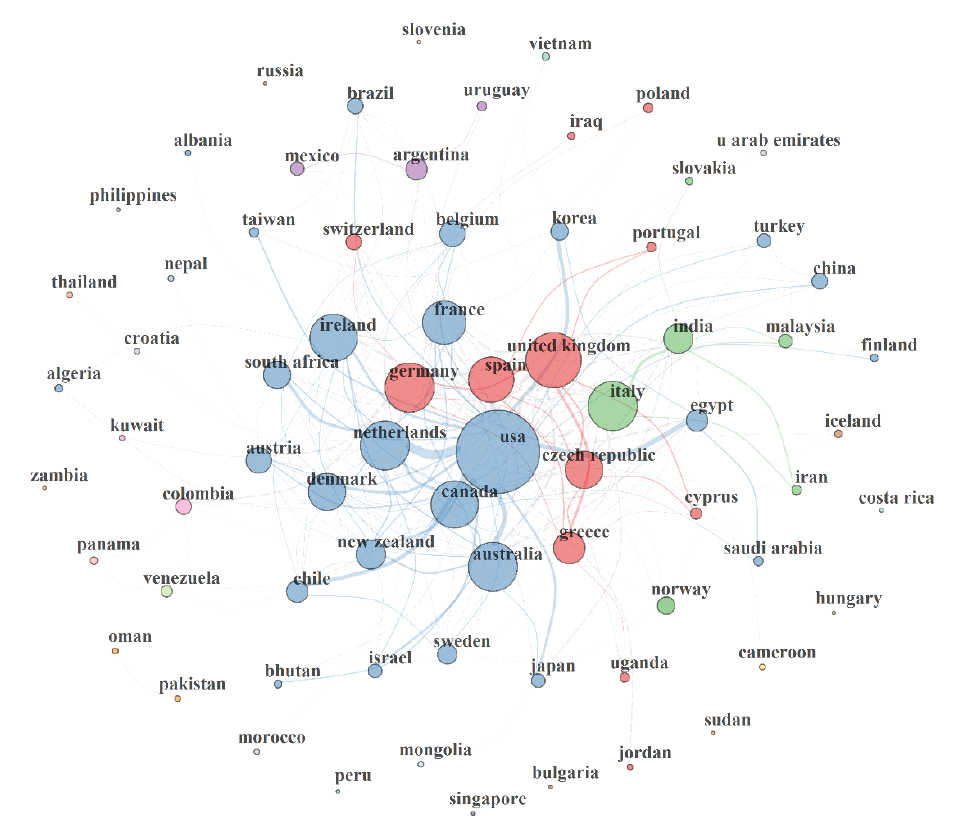
Figure 4. Country collaboration network (CCN) in MAP research from 1911–2019. The collaborative network performance statistics include size = 72; density = 0.099; transitivity = 0.438; diameter = 4; degree of centralization = 0.464; average path length = 2.142; closeness of centralization = 0.027; betweenness of centralization = 0.214; eigenvector of centralization = 0.768; networkDegreeDist = 41. The circle volume of each country correspond to its sharing strength / publication count, connecting curve / line between two countries indicated bidirectional relationship between the countries; the thickness of the curve / line revealed strength of the bidirectional collaborative relationships; countries with the same colour or similar coloured link belong to the same cluster of collaborative community.